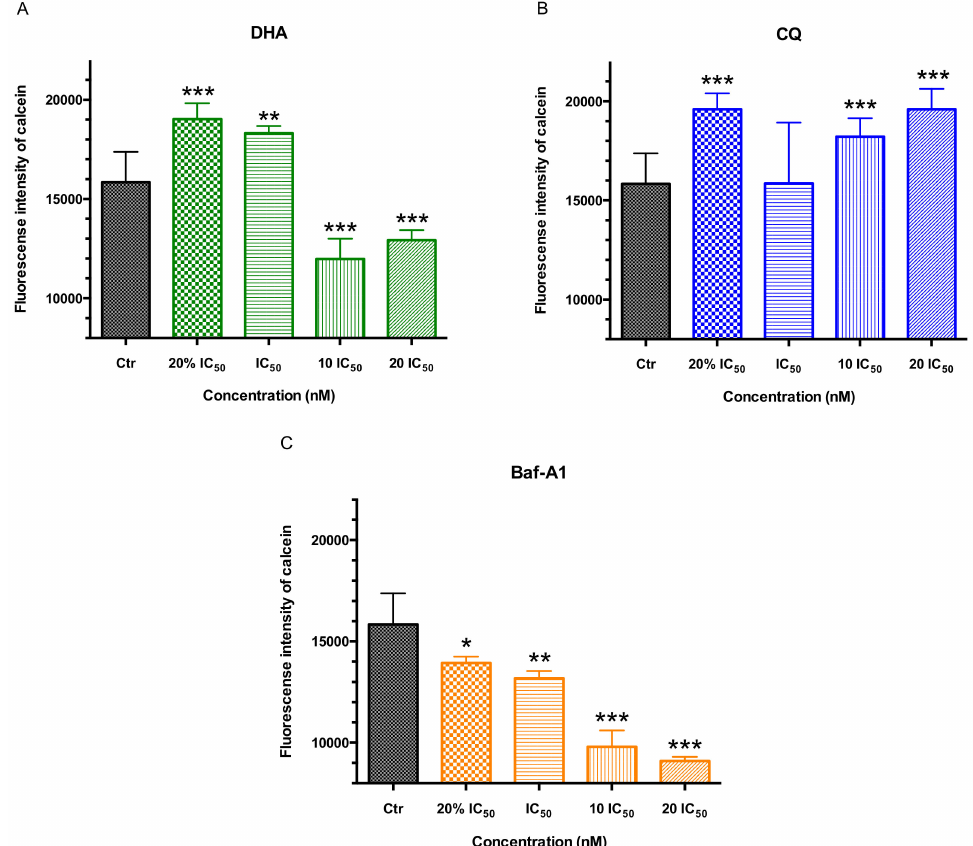
Figure 6. The fluorescence intensity of intracellular irons at trophozoite stage P. f 3D7 staining with calcein, AM after 2 h of single drug treatment with a series dose of antimalarial drugs DHA / CQ or V-ATPase inhibitor Baf-A1 by flow cytometry. ( A ) Fluorescence intensity of BCECF in trophozoite stage P. f 3D7 treated by DHA; ( B ) Fluorescence intensity of BCECF in trophozoite stage P. f 3D7 treated by CQ; ( C ) Fluorescence intensity of BCECF in trophozoite stage P. f 3D7 treated by Baf-A1. Ctr means control. Data shown are mean ± SEM (n ≥ 3). * p < 0.05, ** p < 0.01 or *** p < 0.001 vs.